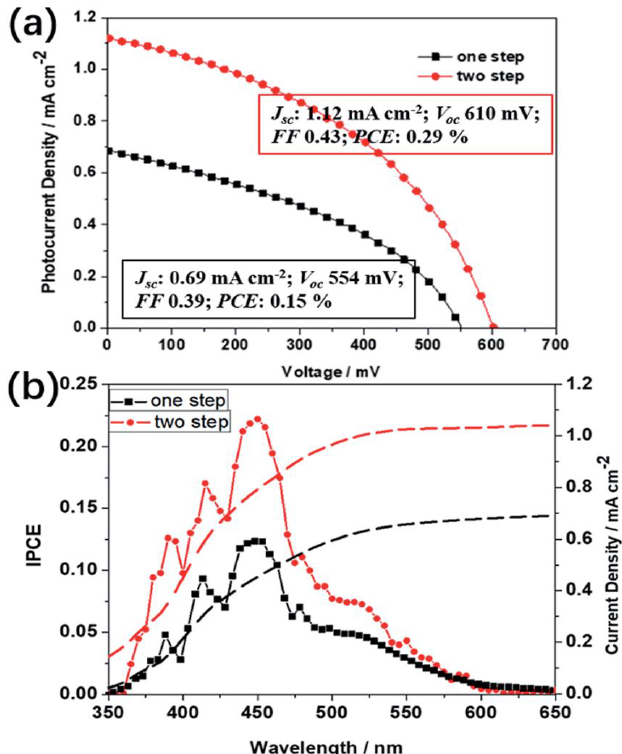
Figure 6. ( a ) J-V curves for the best performing devices by the one-step and the two-step method, respectively, measured under simulated AM1.5 G irradiation; ( b ) Corresponding IPCEs. Re-used with